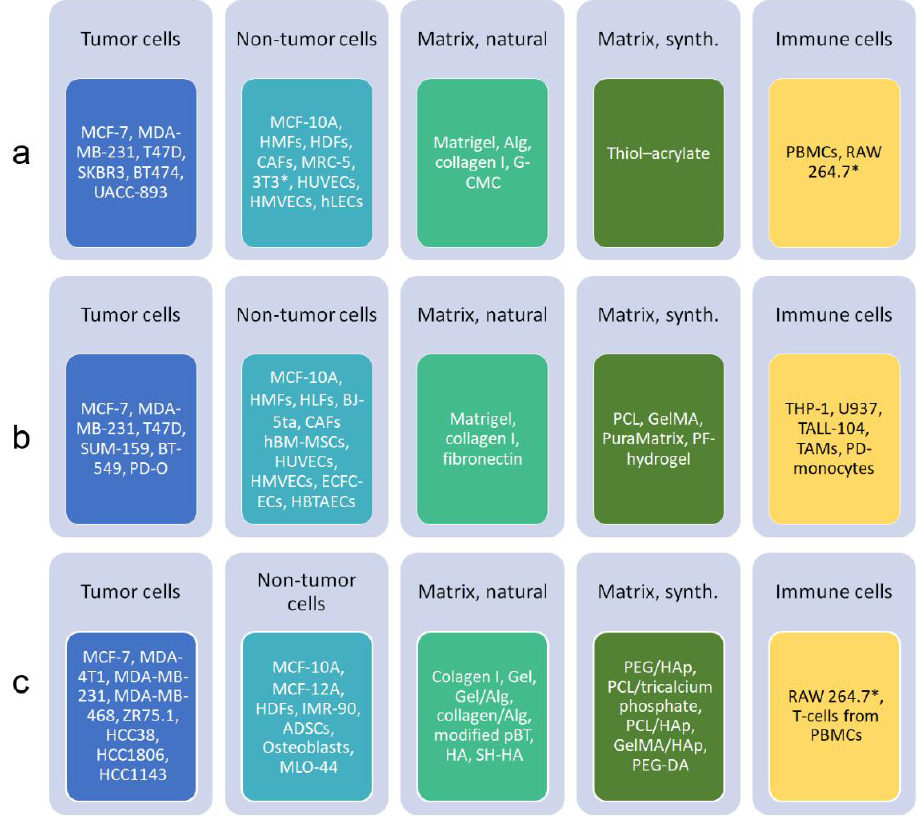
Figure 4. Overview of cells and scaffold materials, which were used in spheroids or organoids (( a ), [104]), microfluidic systems (( b ), [50,105]) and 3D bioprinting (( c ), [106,107]) in BC research. The focus is on TME and bone metastasis. Due to lack of space, cells used in models of metas- tasis to other organs are not included. Abbreviations: ADSCs, adipose-derived stem cells; Alg, alginate; BJ-5ta, hTERT-immortalized fibroblasts; CAFs, cancer-associated fibroblasts; ECFC-ECs, endothelial colony-forming cells; G-CMC, gelatin-carboxymethyl cellulose; Gel, gelatin; GelMA, gelatin methacrylate; HA, hyaluronic acid; HAp, hydroxyapatite; HBTAECs, primary human-breast- tumor-associated endothelial cells; hBM-MSCs, human bone marrow mesenchymal stem cells; HDFs, human dermal fibroblasts; hLECs, human lymphatic endothelial cells; HLFs, human lung fibroblasts; HMFs, human mammary fibroblasts; HMVECs, human microvascular endothelial cells; HMT1937, non-tumorigenic breast cells; HUVECs, human umbilical vein endothelial cells; IMR90, fibroblasts; MLO-44, osteocyte-like cells; PBMCs, peripheral blood mononuclear cells; pBT, porcine breast tis- sue; PCL, polycaprolactone; PD, patient-derived; PEG, polyethylene glycol; PEG–DA, polyethylene glycol diacrylate; PF, polyethylene glycol/fibrinogen; RAW264.7, macrophages; SH-HA, hyaluronic acid with thiol groups; 3T3, fibroblasts; TALL-104, T-lymphoblast cell line; TAMs, tumor-associated macrophages; THP-1, monocytic leukemia cells; U937, pro-monocytic myeloid leukemia cells. Murine cells are marked by